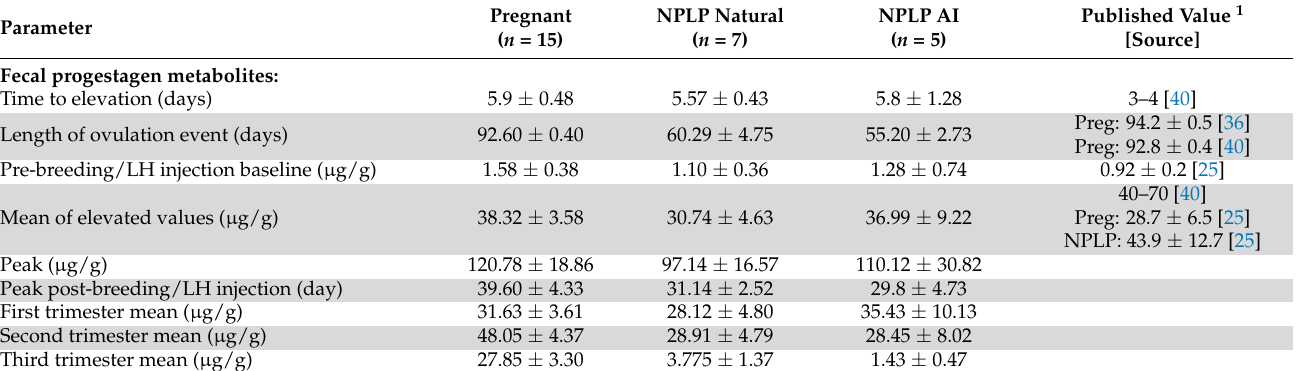
Table 2. Ovarian and adrenal fecal hormone metabolite characteristics of cheetahs that ovulated and gave birth (pregnant), ovulated after natural breeding and did not give birth (natural non- pregnant luteal phase; NPLP natural), ovulated after exogenous hormone administration for artificial insemination, and did not give birth (AI non-pregnant luteal phase; NPLP AI). Ovulation events were measured from breeding or hCG/LH administration (abbreviated as LH injection) date to birth for pregnant females and date progestagen metabolites dropped to baseline concentrations for NPLP females. Values shown are group means ±